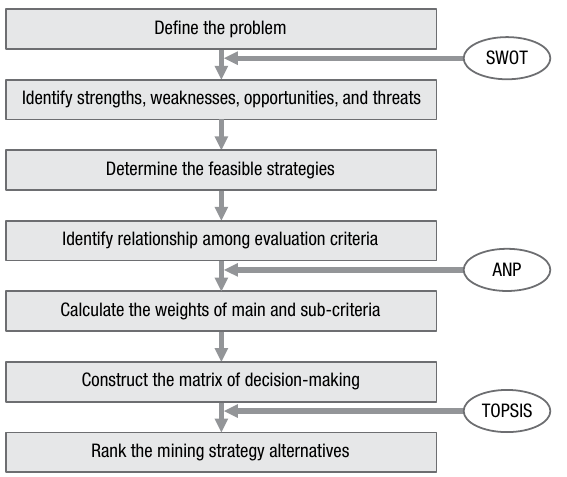
Fig. 3. Schematic diagram of the proposed